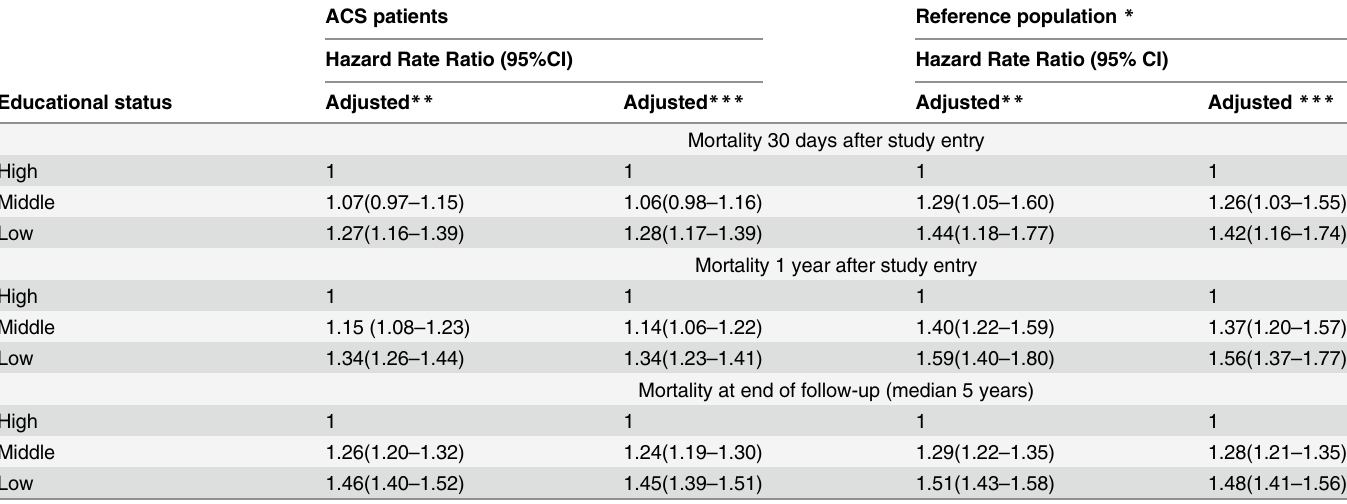
Table 3. Association between educational status and all-cause mortality in patients admitted first time with acute coronary syndrome (ACS) and a reference population in